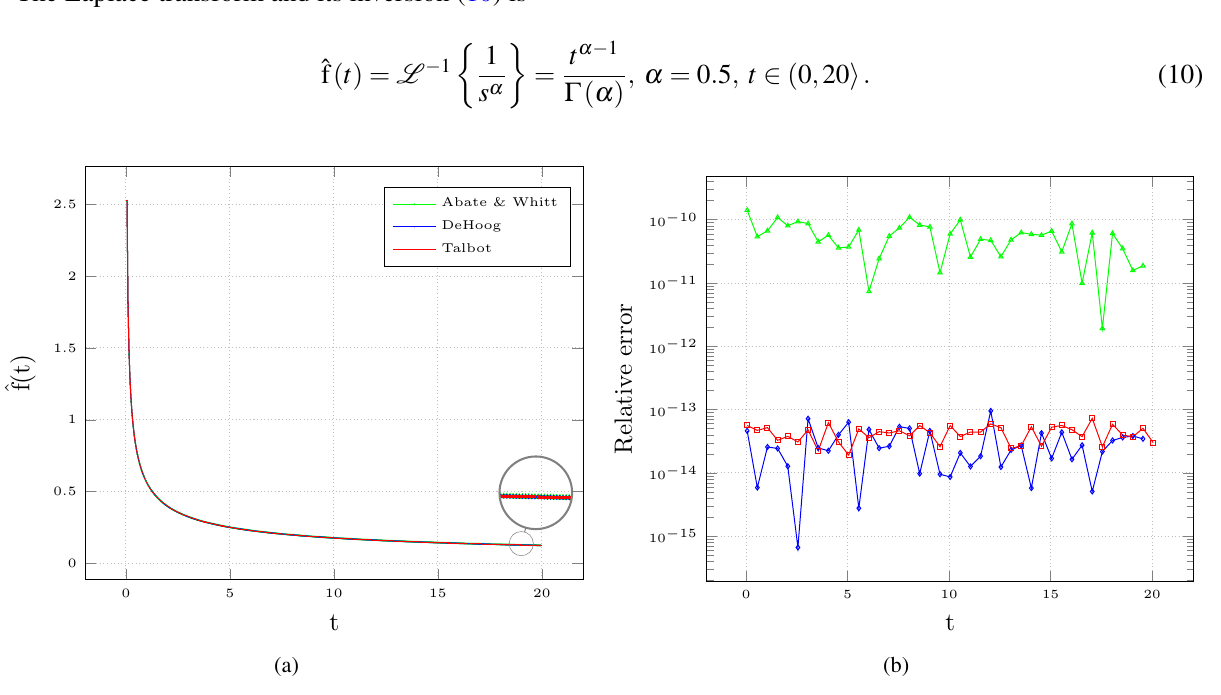
Fig. 10 Plots of numerical inversions ˆf ( t ) of the Laplace transform (10) (a) and their relative errors (b) for applied methods in interval ( 0 , 20 (cid:105)